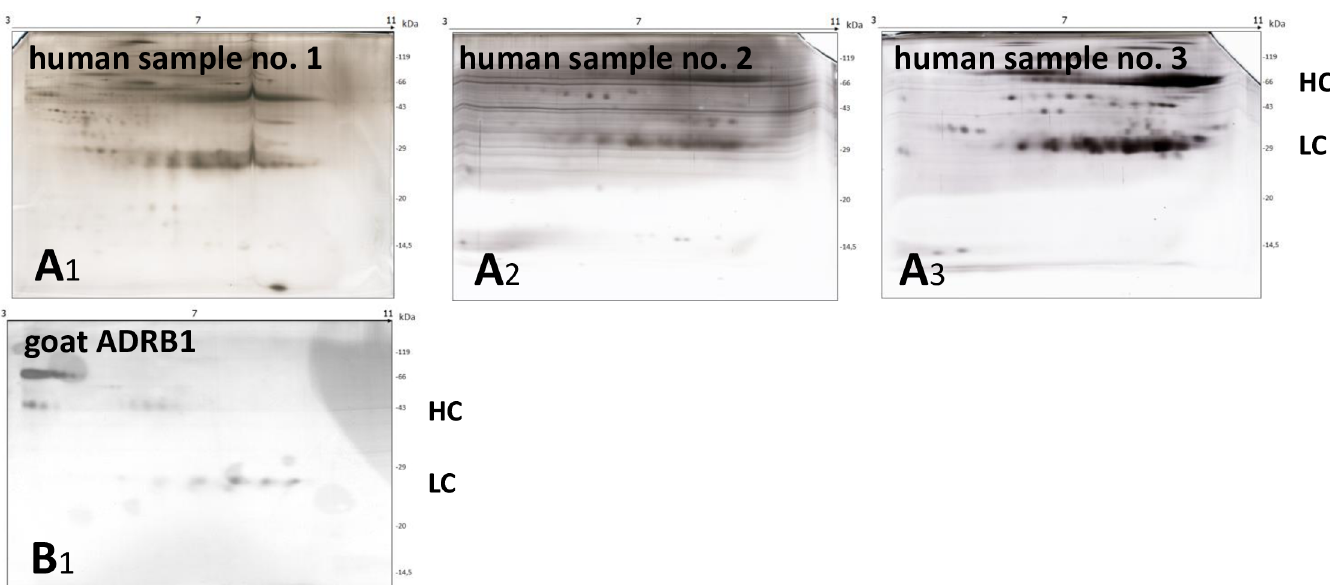
Fig 5. 2DE Gel of beta1-AAB. A1-3: 3 samples of human origin (beta1-AAB enriched samples) and B1: goat anti-human beta1-AB (ADRB1-AB). For gel conditions see under Material and methods.